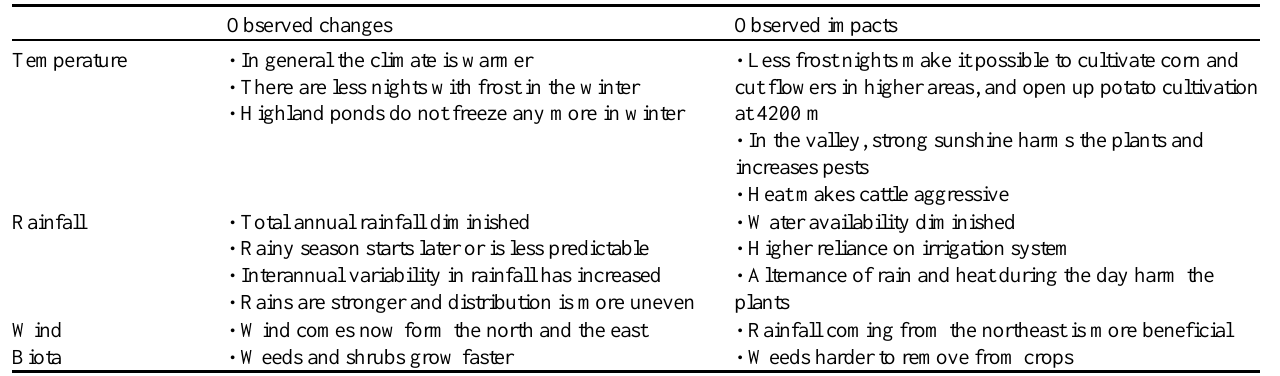
Table 2 . Observed weather changes and their impact in